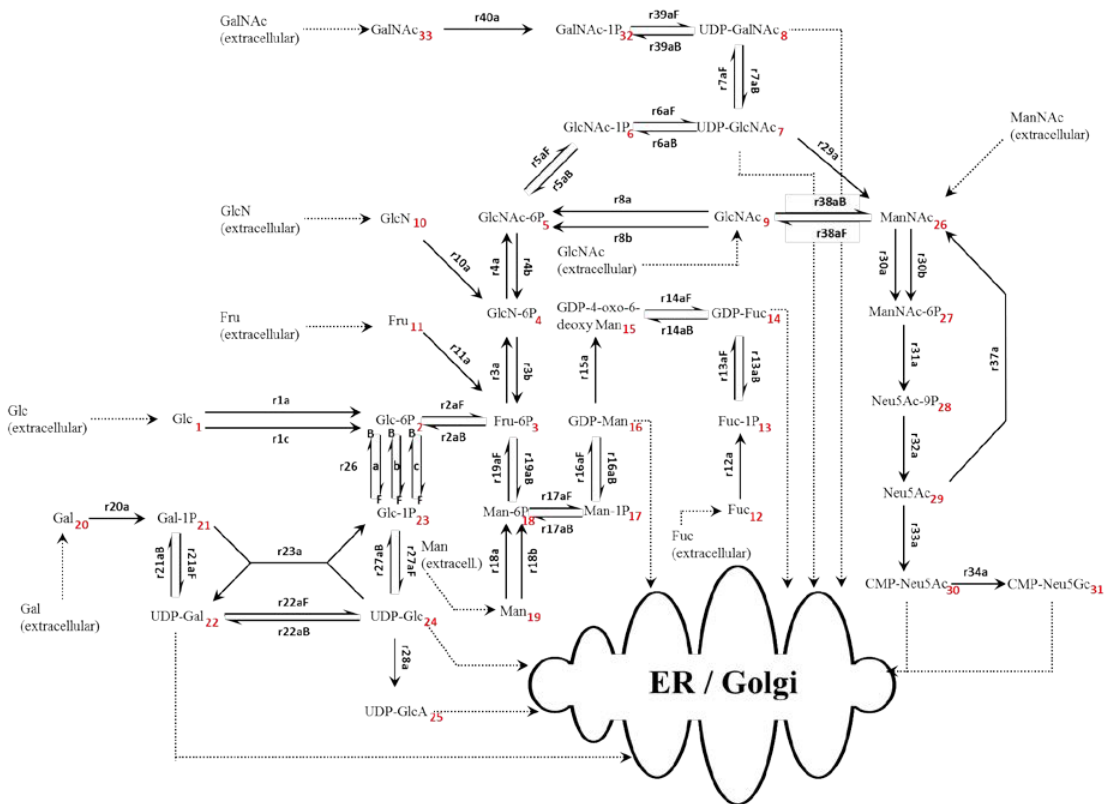
Figure 3. Reaction network including all steps considered in the